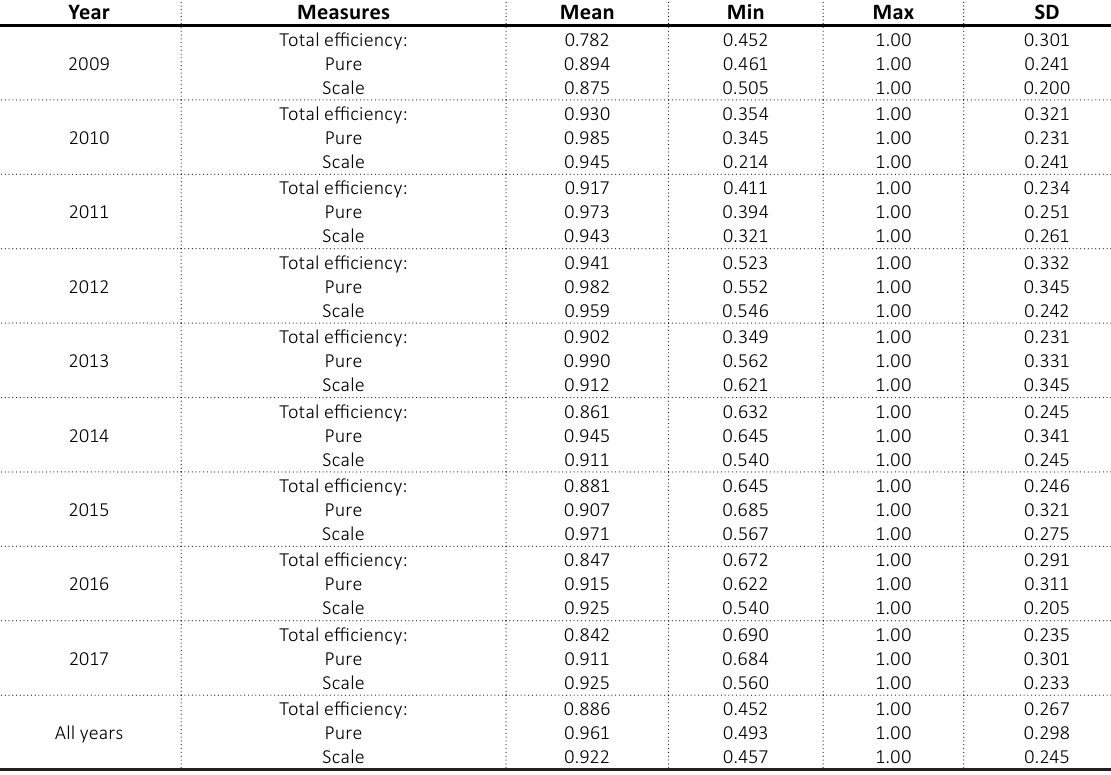
Table 11. Measures of efficiency of Islamic banks after the crisis